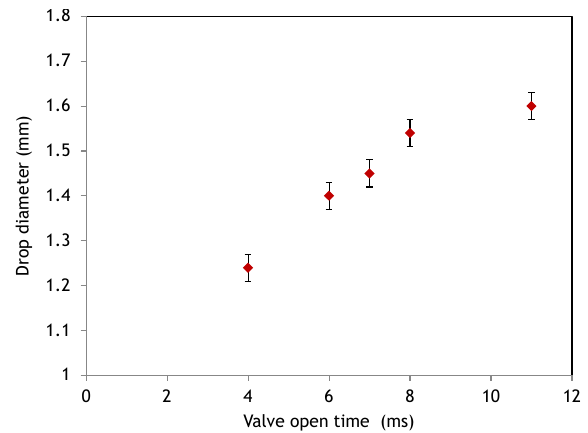
Figure 4. Measured equivalent diameter of the drop produced by our generator as a function of the valve opening time (for an over- pressure of